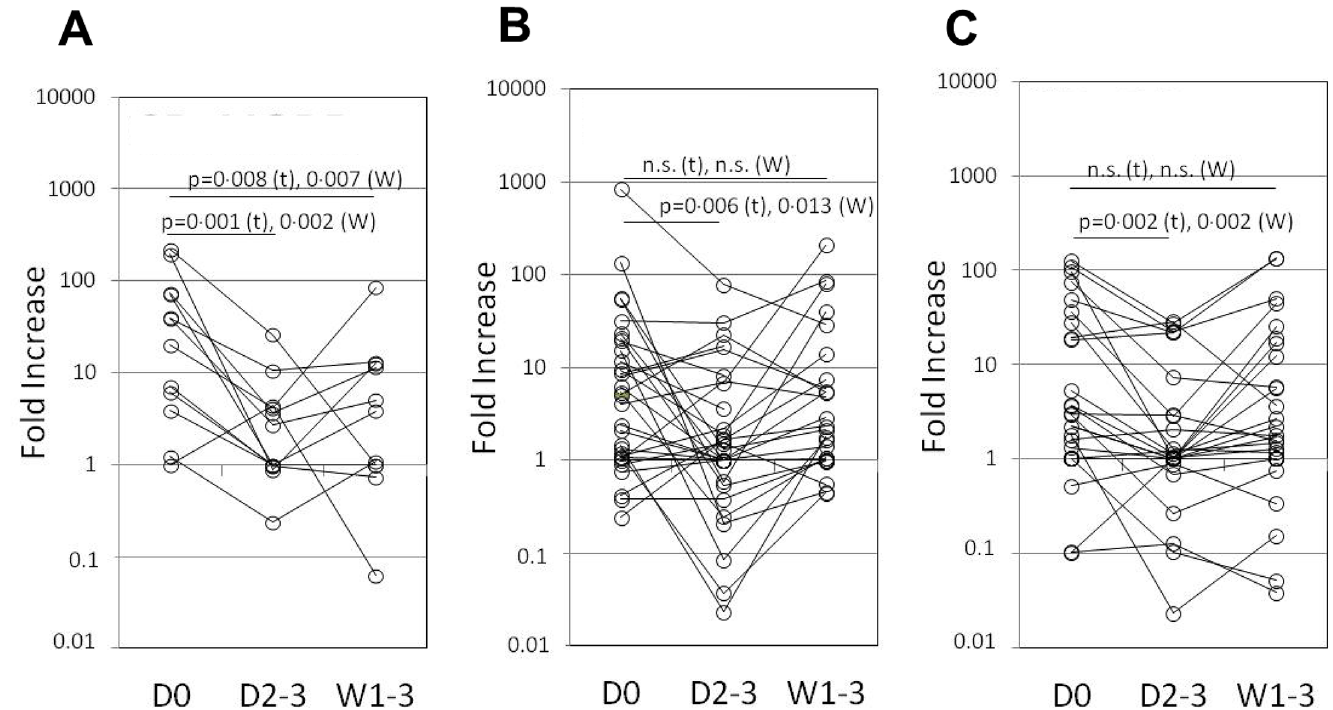
Fig 2. LPS-induced CXCL10 expression before and after bortezomib treatment. Each point/line represents the fold increase in LPS-induced CXCL10 expression in each patient in the (A) CR+VGPR, (B) PR and (C) SD+PD groups. The statistically significant difference between the pretreatment (D0) and 2 – 3 days (D2-3) or 1 – 3 weeks (W1-3) after intravenous administration of the first dose of bortezomib during the first cycle groups is shown. t: Student ’ s t -test, W: Wilcoxon